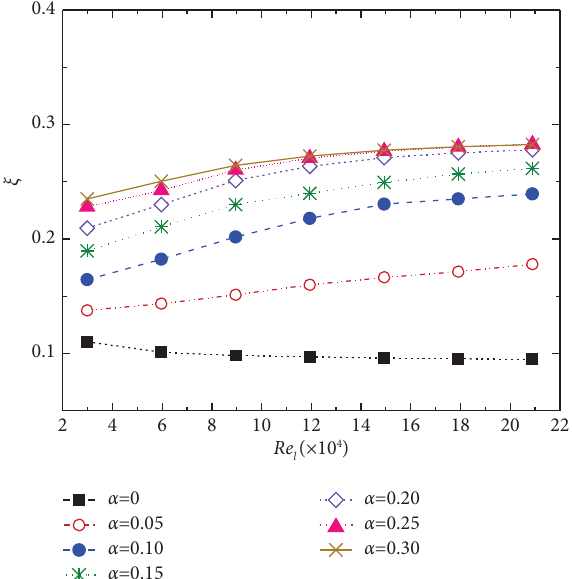
Figure 8: Relationship curves of ξ with Re vertical L-shaped pipes.